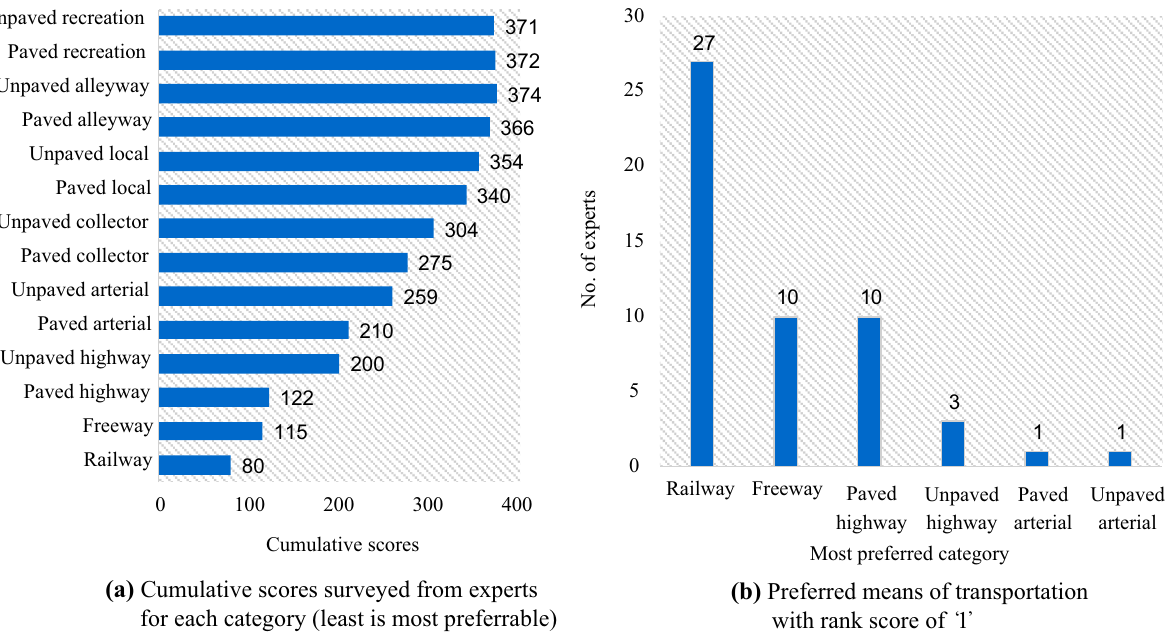
Fig. 3 Preference scores and the most preferred means of transportation for nuclear materials